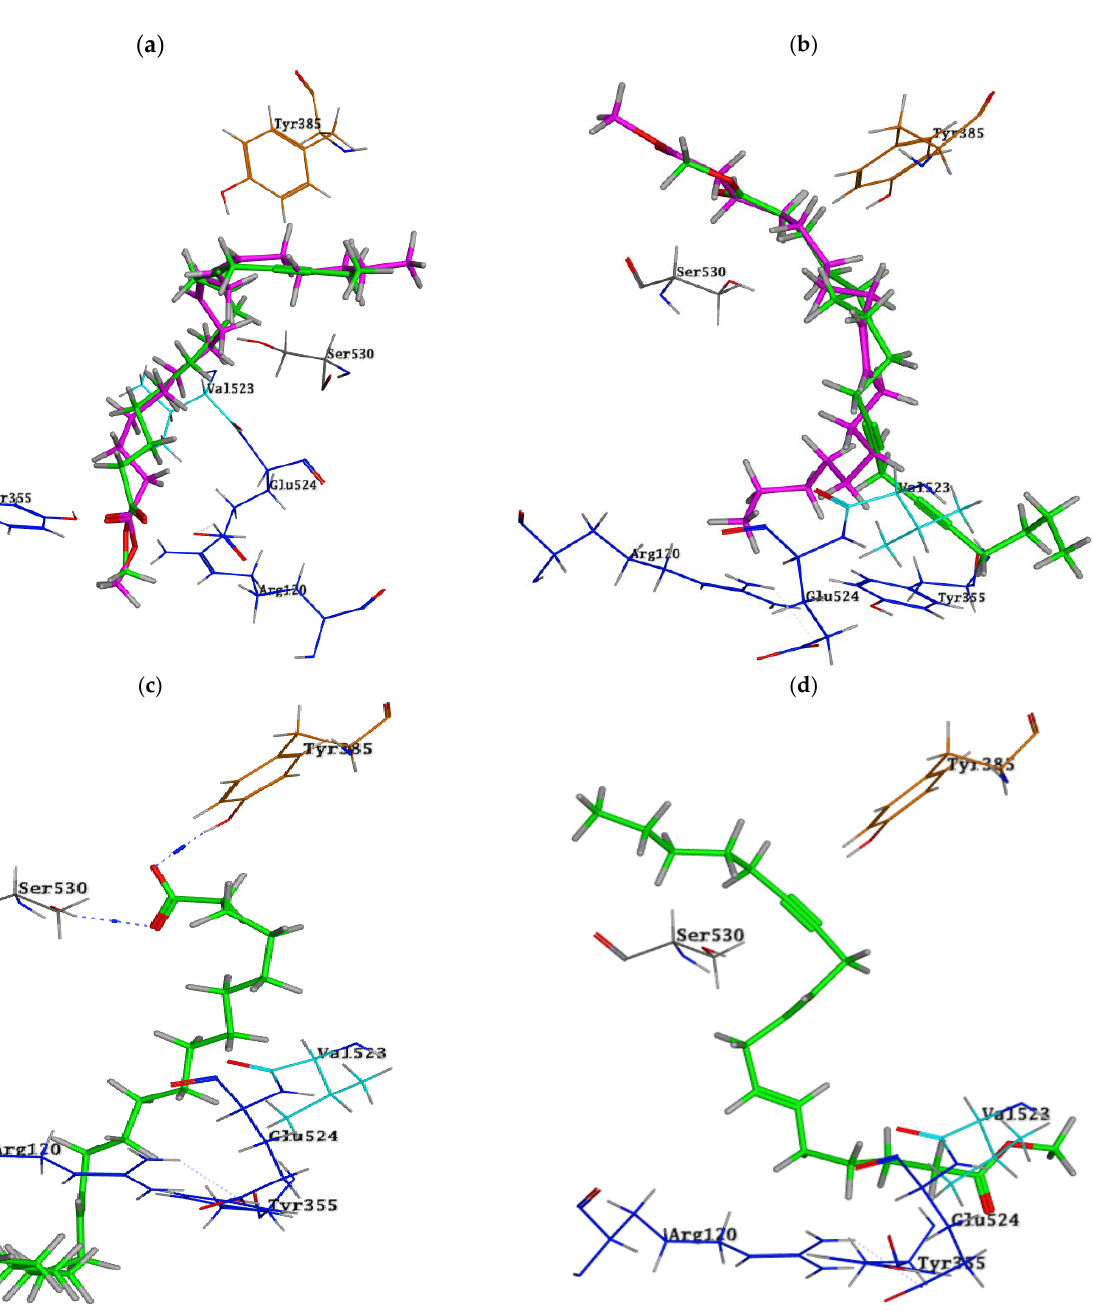
Figure 2. Binding poses of ( a ) metabolites 17 “green” and 43 “magenta”, ( b ) metabolites 30 “green” and 44 “magenta”, ( c ) metabolite 49 and ( d ) metabolite 32 into COX-2 active site; ligands are depicted in the stick model. The residues are shown in labelled wire models.